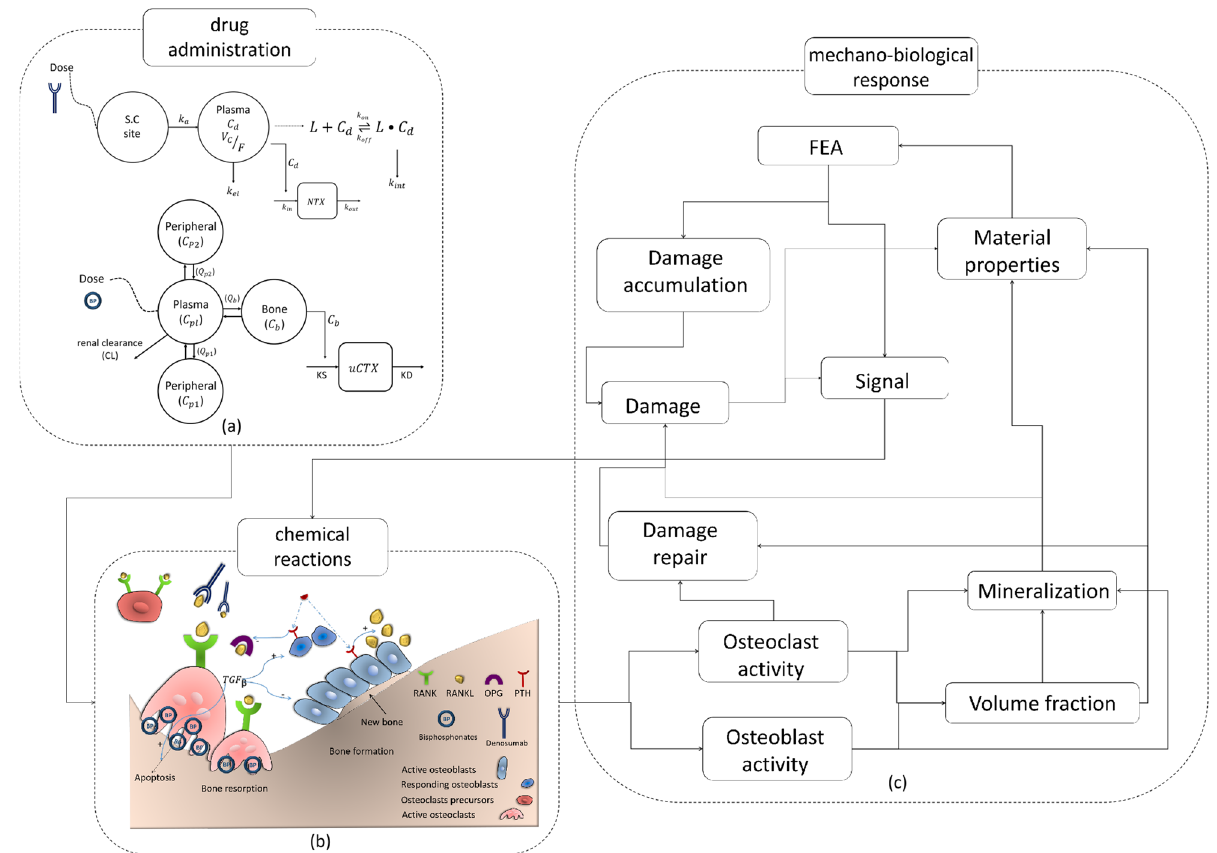
Figure 11. Schematic representation of the bone remodeling model coupled with drug administration: ( a ) PK/ PD models for denosumab (top) and for Ibandronate (bottom); ( b ) effect of the biochemical pathway and bone cells; ( c ) flowchart of mechano-biological response bone remodeling